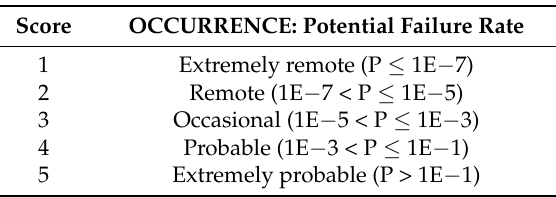
Table 1. Occurrence